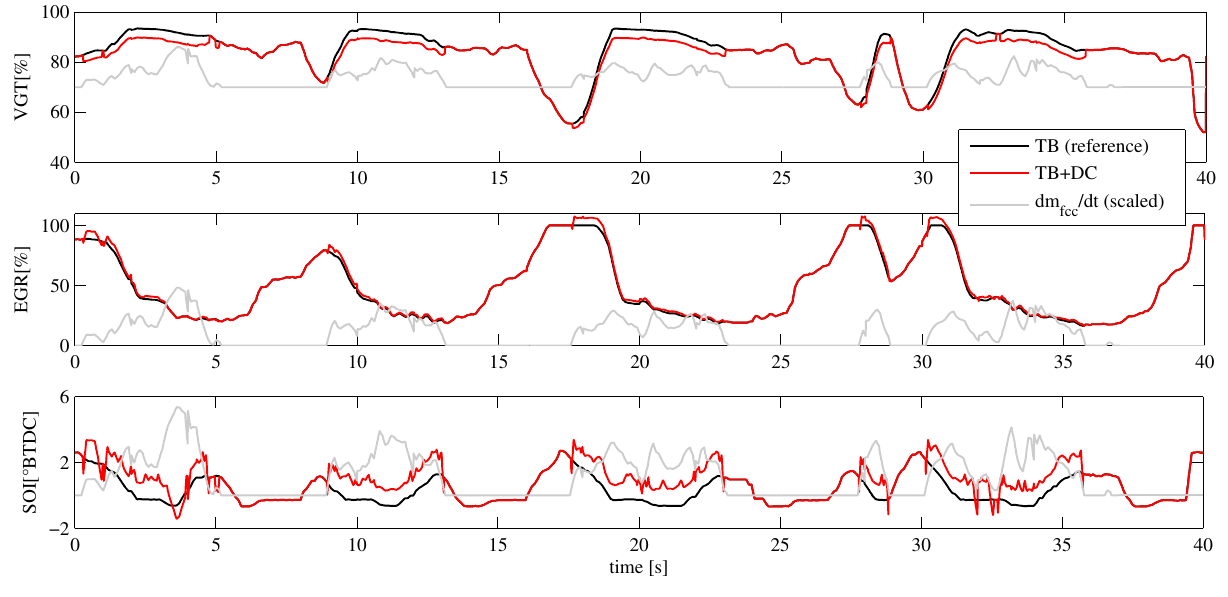
Figure 15. Control signals for Case 1. In order to highlight when the compensation occurs, the fuel derivative trend is superimposed on the